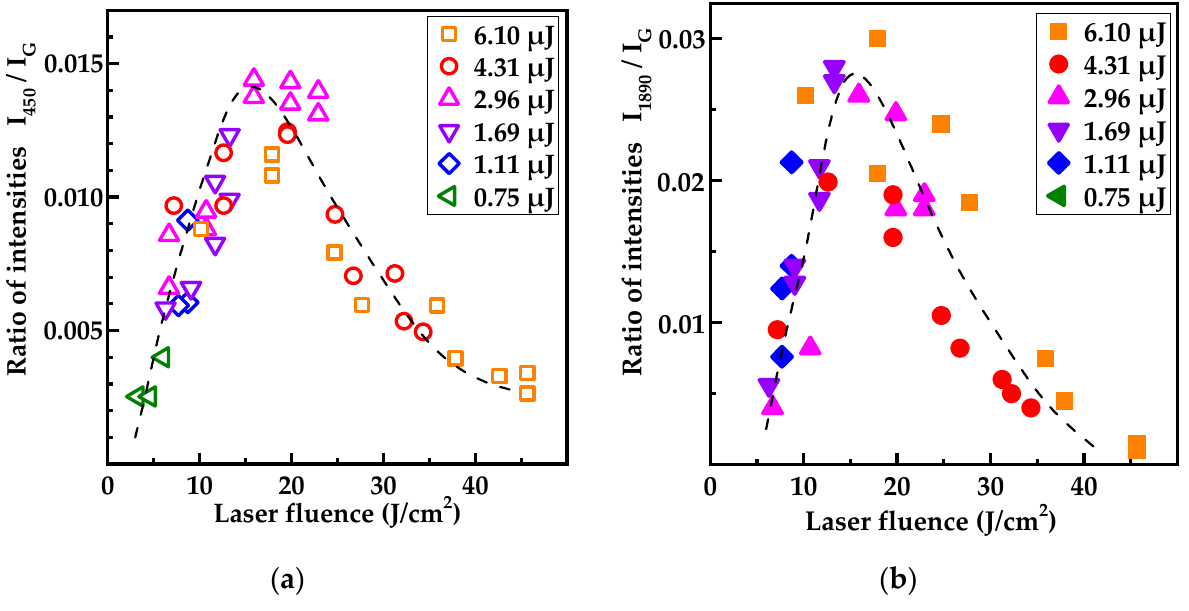
Figure 9. The ratio between intensities of the various bands to the G peak in the Raman spectra: ( a ) 455 cm –1 band; ( b ) 1890 cm –1 band. Legend denotes the energies at which the spots explored were produced. Dotted curves shown as eye guides only.